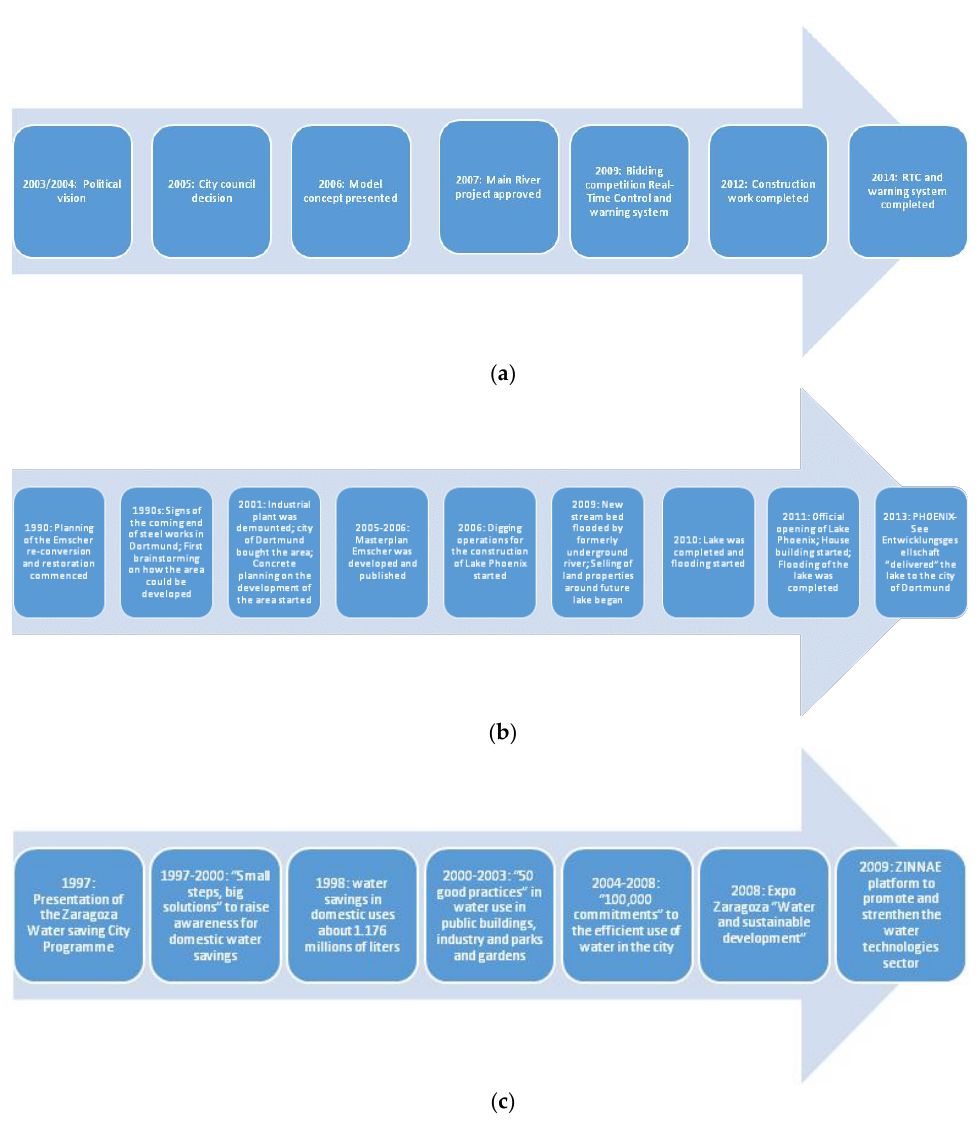
Figure 2. Timelines of key events in the three case studies. ( a ) Timeline of key events in the Aarhus case study; ( b ) Timeline of key events in the Emscher case study; ( c ) Timeline of key events in the Zaragoza case